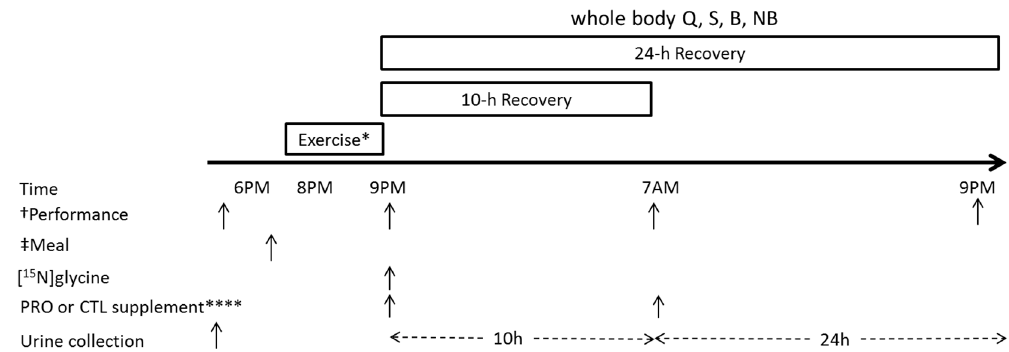
Figure 1. A schematic representation of the trial day. Participants were free-living in recovery and consumed a controlled diet that mimicked their habitual dietary intake. * Exercise: on supplemented trials only; whole body, heavy resistance exercise. † Isometric maximal voluntary contraction, squat jump, Wingate test, knee extension repetitions to failure at 75% of 1-repetition maximum. ‡ Mixed-macronutrient meal. A twenty-five gram (25 g) whey protein supplement (PRO) or isocaloric carbohydrate (control; CTL) supplement. Q, nitrogen turnover; S, whole body protein synthesis; B, whole body protein breakdown; NB, whole body net protein balance. Urine collection was collected over two intervals: 0–10 h, and 10–24 h; after obtaining a sample from the 0–10 collection, both collections were pooled to obtain a 24 h recovery sample.